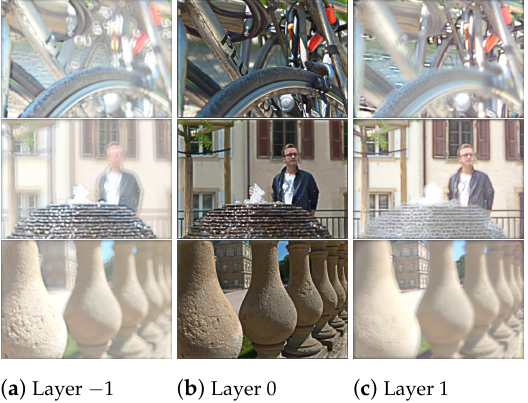
Figure 9. The three multiplicative layers of Bikes , Fountain-Vincent2 , and Stone-Pillars Outside light fields obtained from the convolutional neural network.